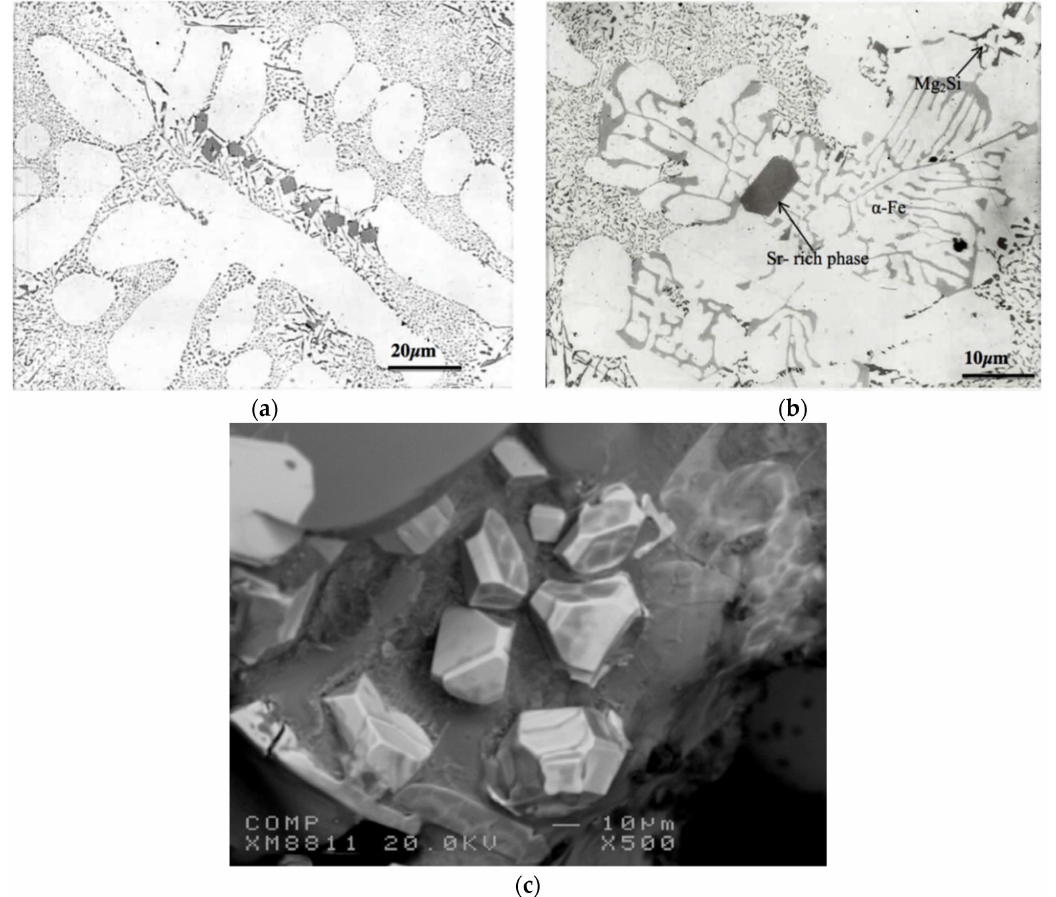
Figure 10. Morphlogy of eutectic Si particles in A1S alloy in the as cast condition: ( a ) segregation of the Sr-rich particles; ( b ) formation of α -Fe and Sr-rich phases; ( c ) an example of the tetrahedral shape of the Al 4 SrSi 2 particles, DAS ~ 25 µ